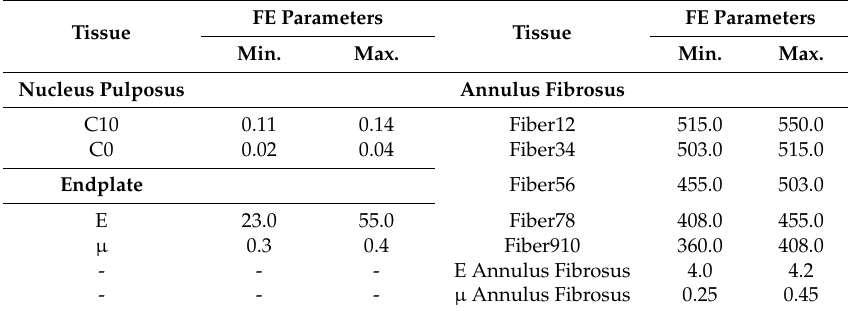
Table 7. Range of the proposed material parameters for defining the behavior of the human intervertebral lumbar disc models based on FEM.